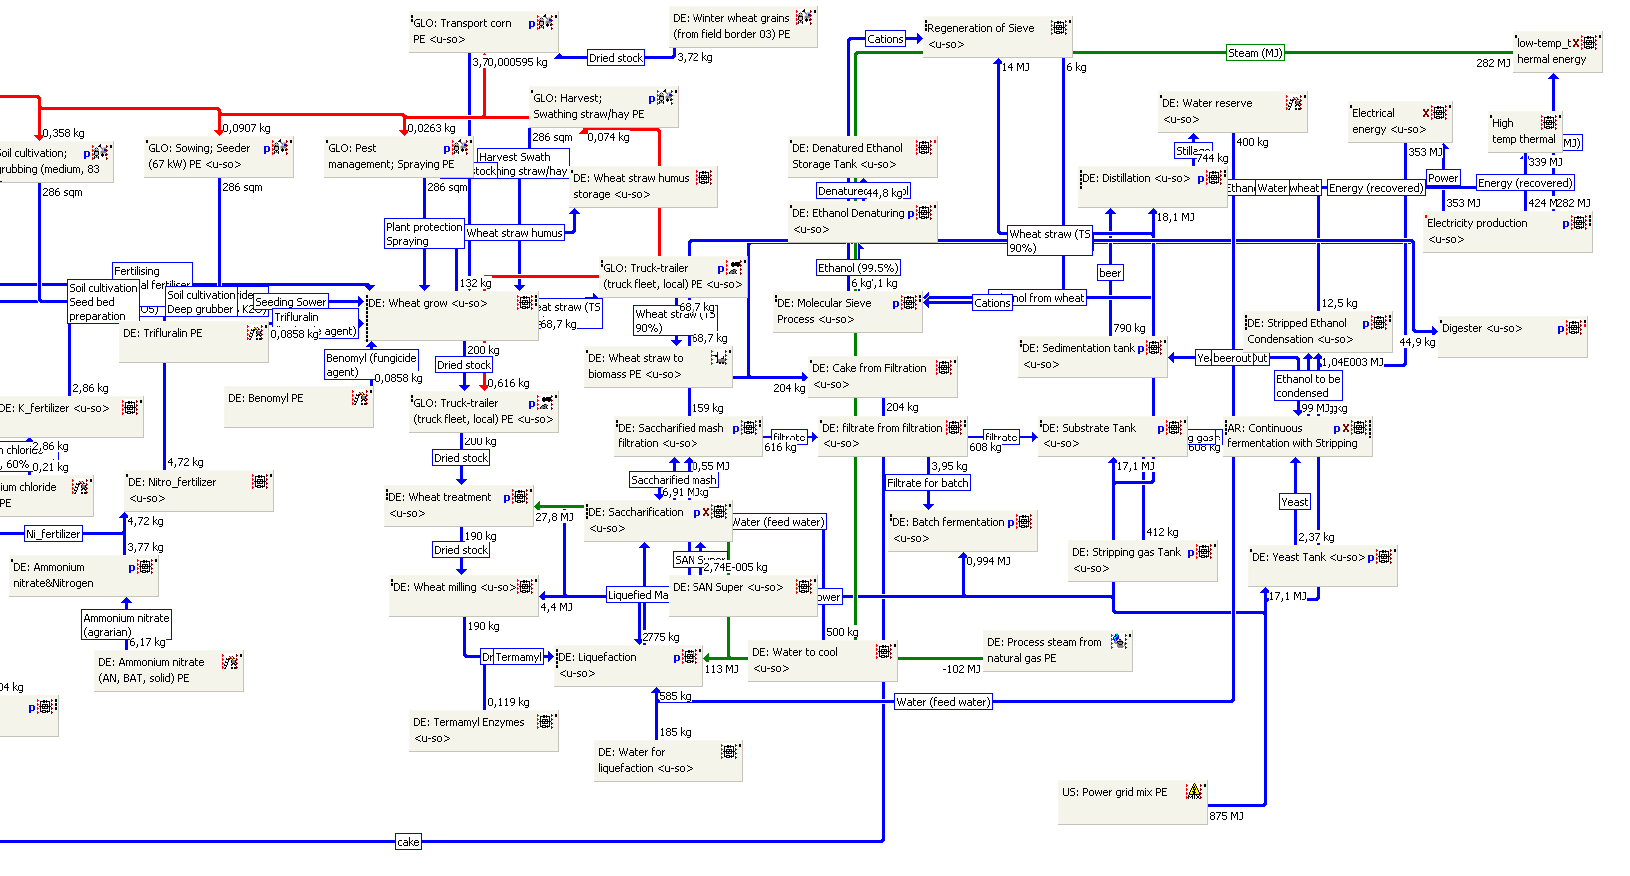
Figure A1. Flowchart for denatured ethanol production process using Blenke cascade system generated by GaBi